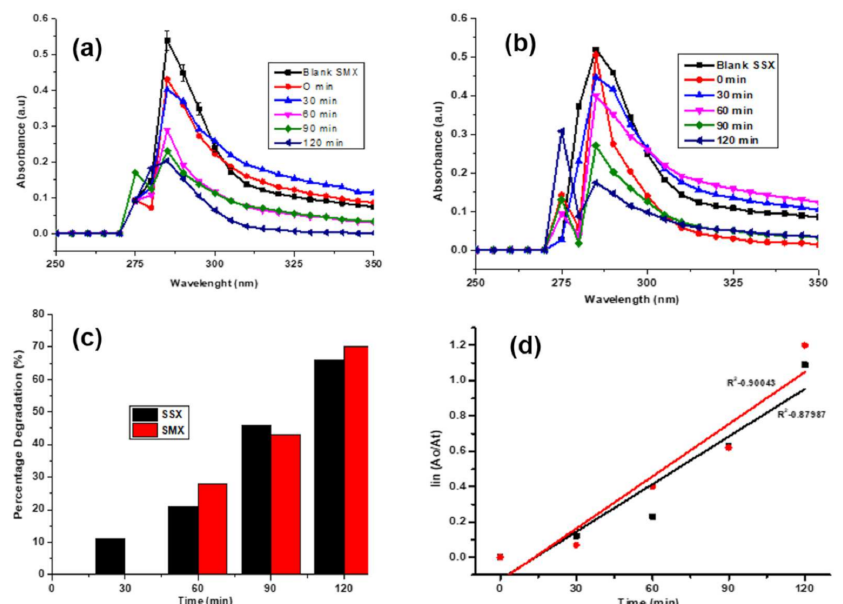
Figure 9. ( a , b ) Absorbance plots of SSX and SMX, respectively, ( c ) percentage degradation of the antibiotics and 9 ( d ) kinetic plots of SSX and